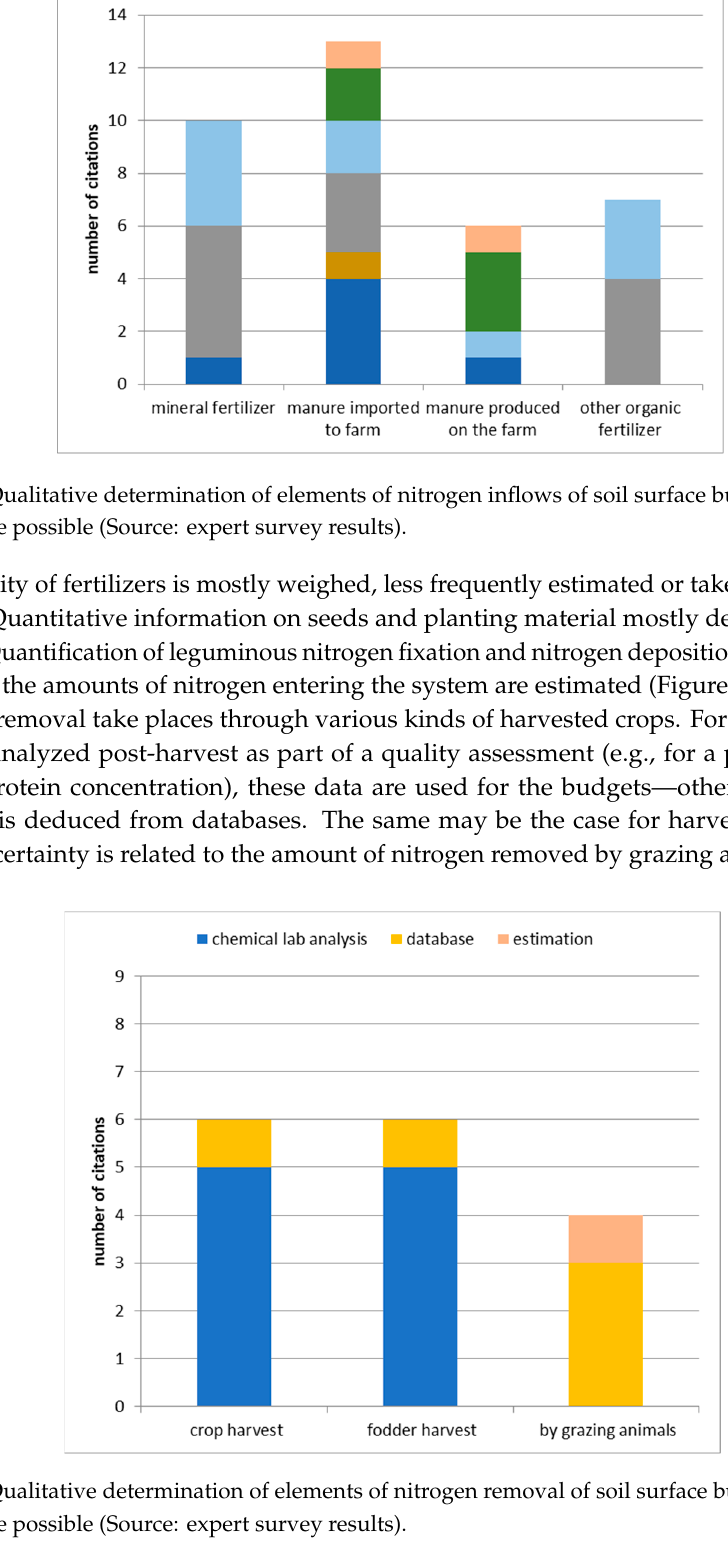
Figure 6. Qualitative determination of elements of nitrogen removal of soil surface budgets; multiple answers are possible (Source: expert survey results).